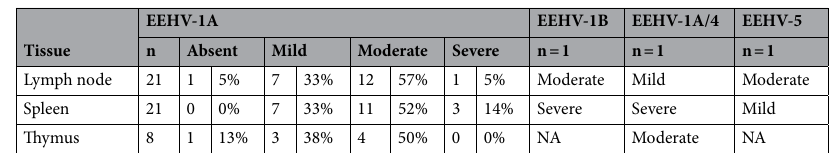
Table 6. Lymphoid depletion scores in organs from Asian elephant endotheliotropic herpesvirus- haemorrhagic disease fatalities in Europe. NA; tissue not available.